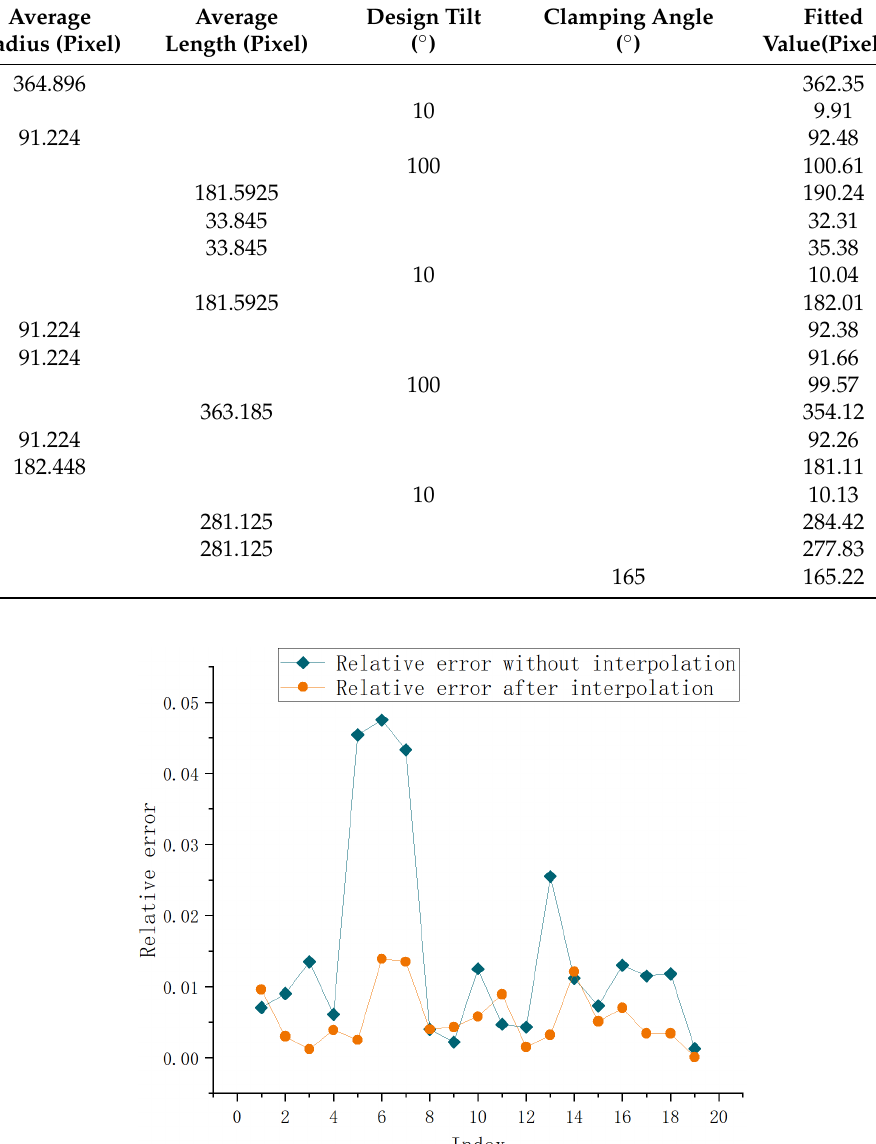
Figure 23. Segmentation points selected from different placement angles.